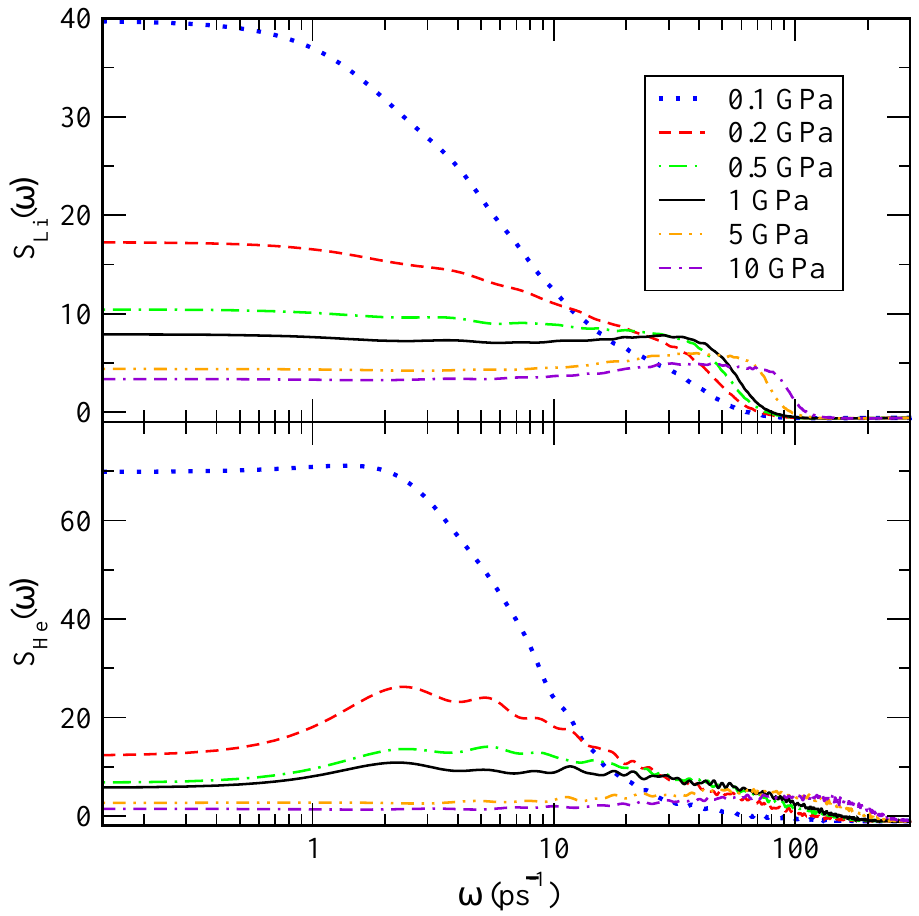
Figure 11. Spectral densities of lithium ( top ) and helium ( bottom ) at 843 K as a function of pressure. Lines: 0.1 GPa (dotted blue); 0.2 GPa (dashed red); 0.5 GPa (dot-dashed green); 1 GPa (black); 5 GPa (dot-dot-dashed orange); 10 GPa (dash-dash-dotted